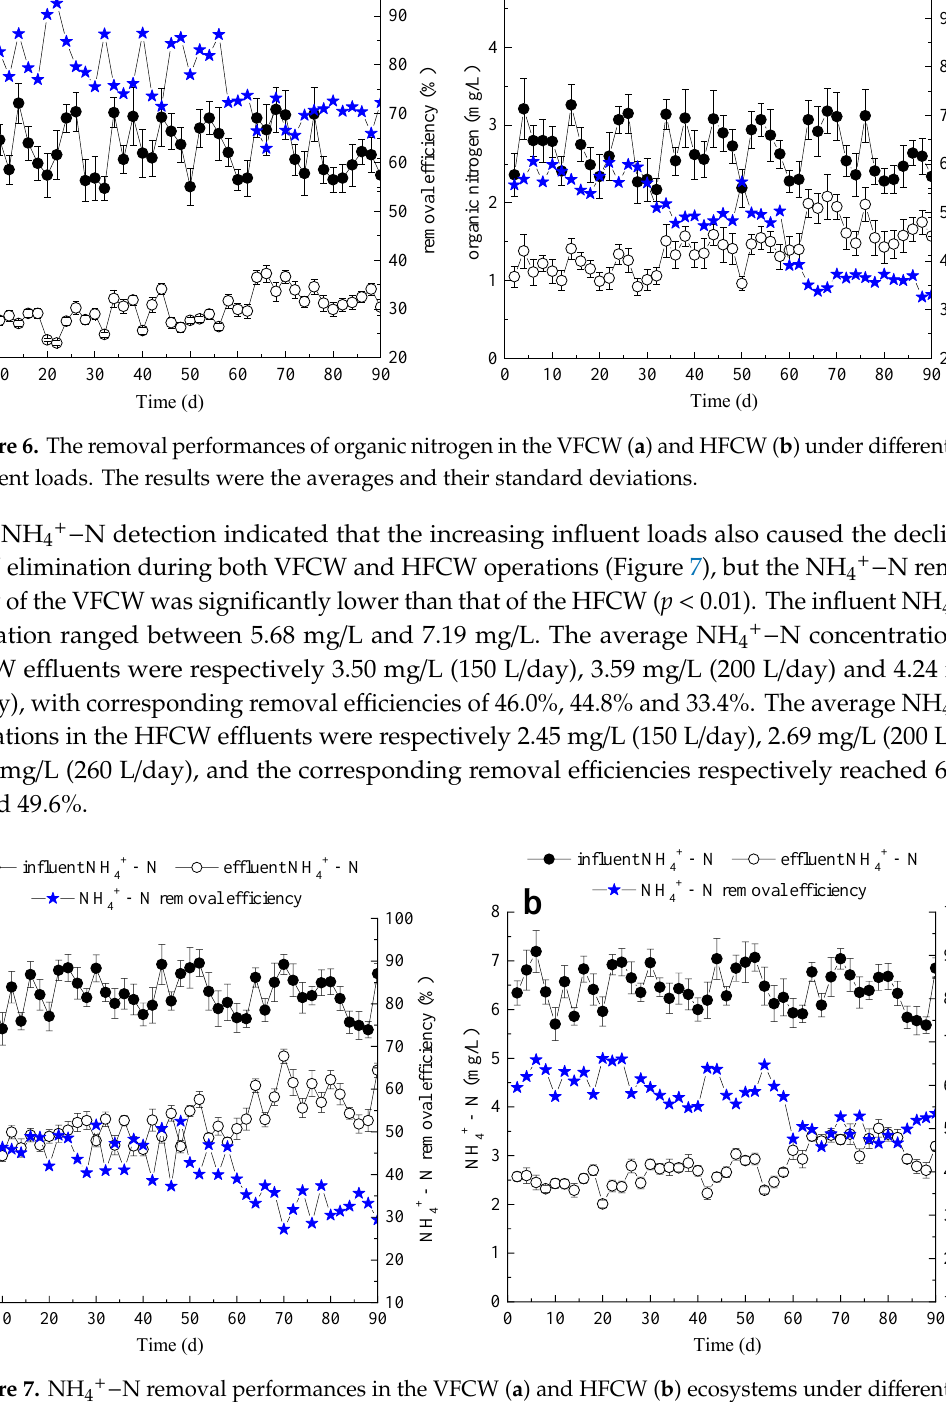
Figure 7. NH 4+ −N removal performances in the VFCW ( a ) and HFCW ( b ) ecosystems under different influent loads. The results were the averages and their standard deviations.